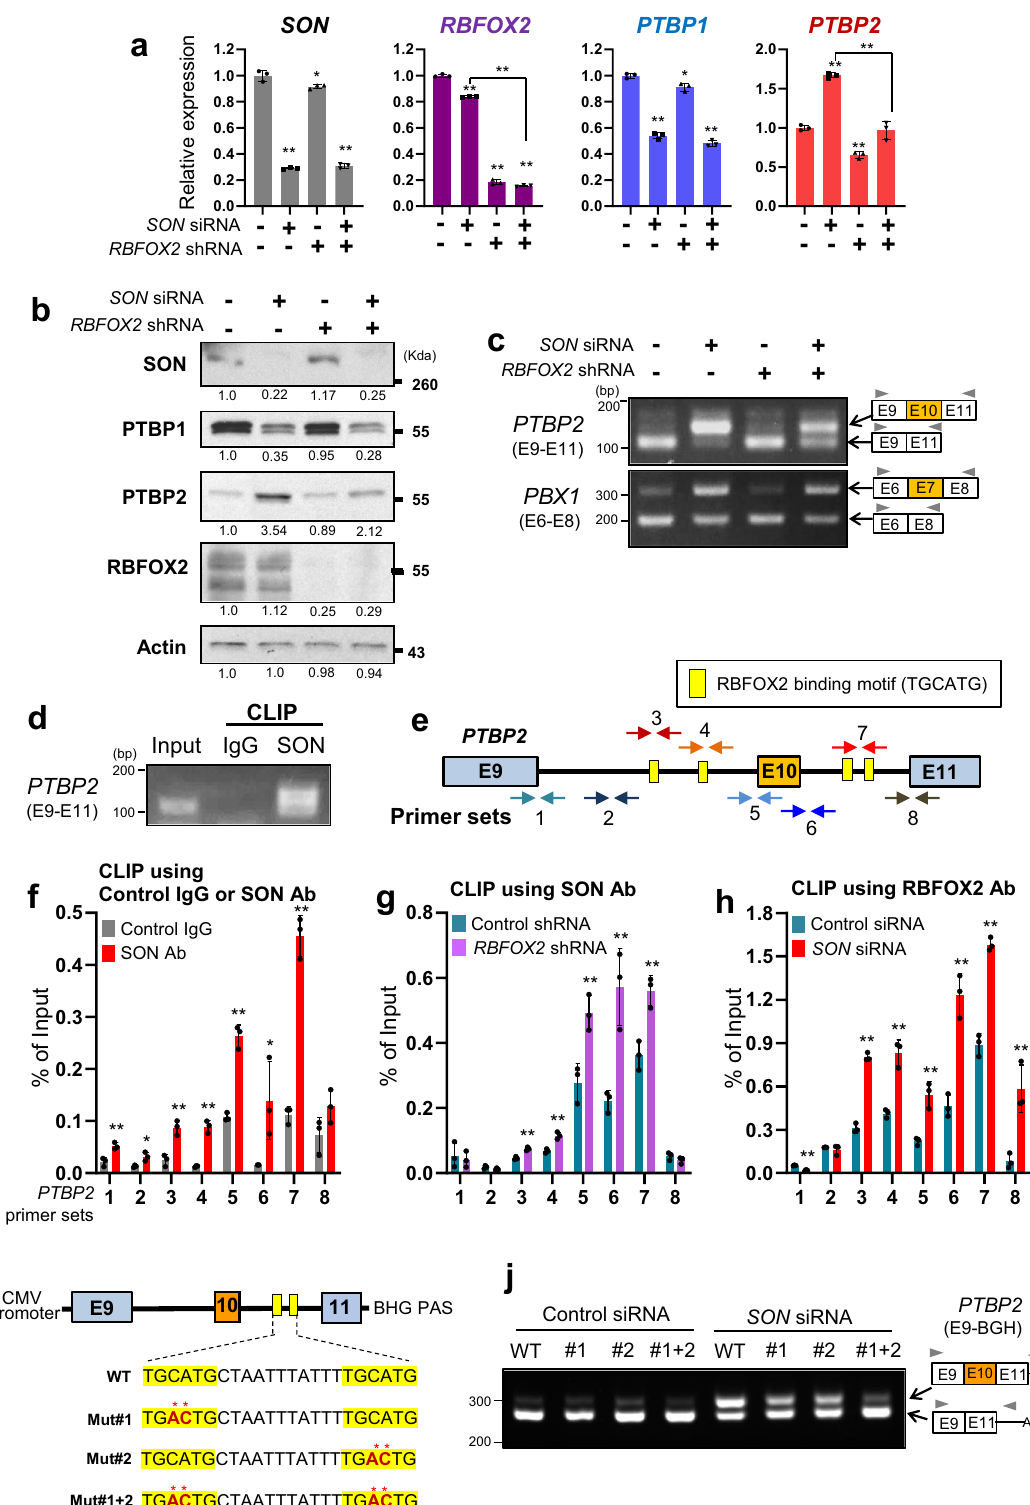
To further corroborate the importance of RBFOX2-binding sites in cassette exon inclusion upon SON knockdown, we used a PTBP2 minigene covering the sequence from exon 9 to exon 11 (Supplementary Fig. 6b). Two RBFOX2-binding motifs are present in the intron downstream of the cassette exon, and we altered these two RBFOX2-binding motifs individually (Mut#1 or Mut#2) and then together (Mut#1 + 2) (Fig. 4i). The minigene